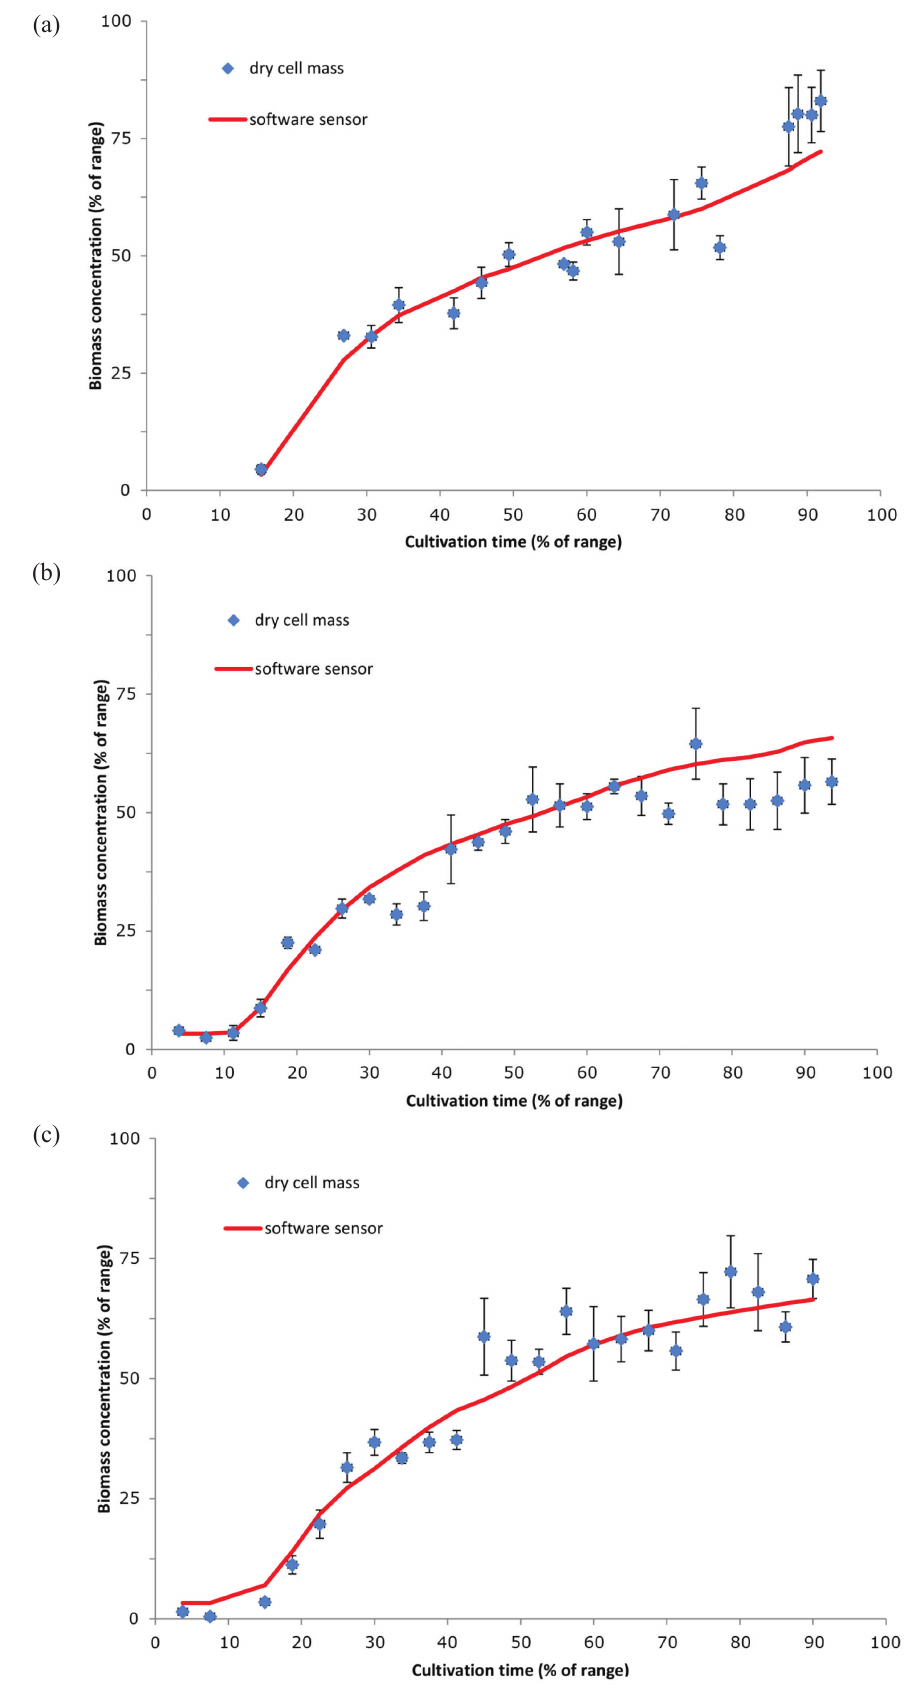
Fig. 5 – Estimation of biomass concentration by software sensor from on-line measured off-gas composition data in cultivations C1–3 (a, b, c) compared to the dry biomass mass values determined by gravimetric